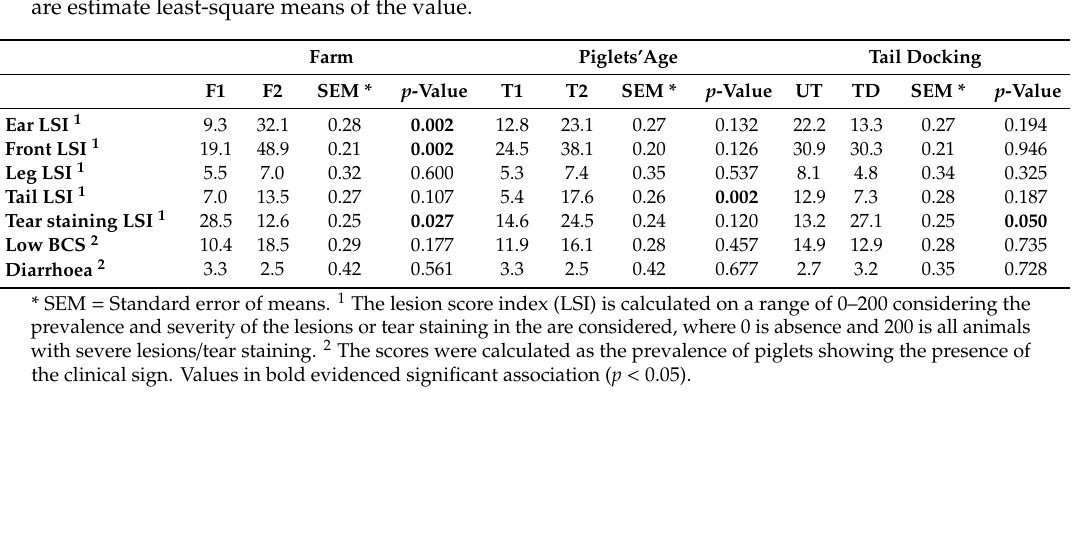
Table 4. Effect of the farm, piglets’ age and tail docking on lesions and health parameters. The numbers are estimate least-square means of the value.